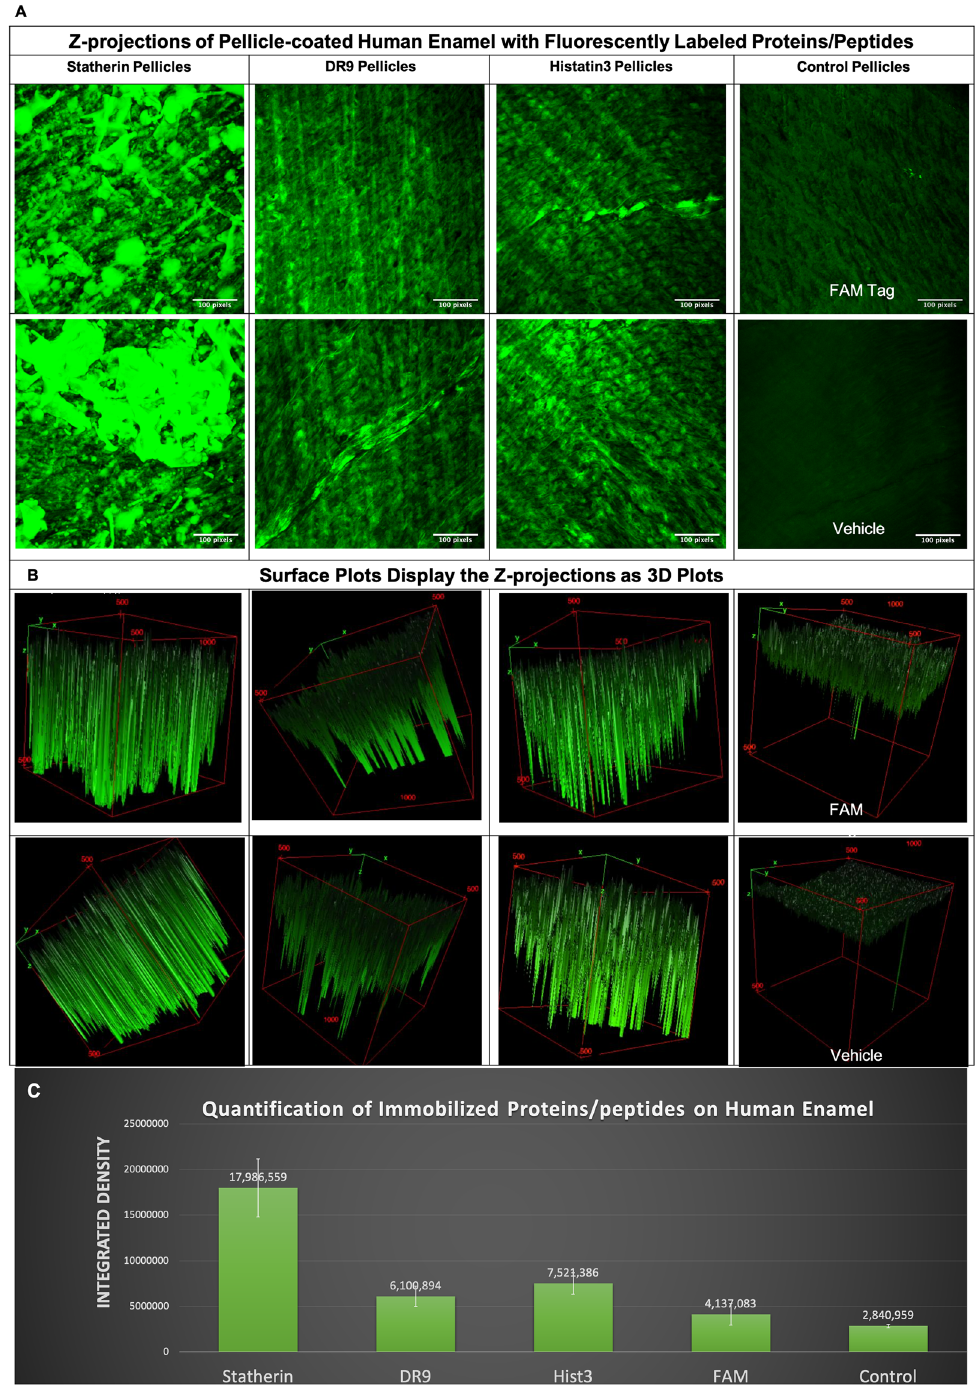
Figure 7. 2-photon Z-projections and 3D surface plots of fluorescently labeled proteins/peptides immobilized on human enamel tissue: This characterization method aimed to visualize the immobilization pattern and binding capacity of representative proteins/peptides. ( A ) Maximum intensity z-projection showing the highest attenuation value throughout the volume onto a 2D image (the scale bar is 25 μm). ( B ) Surface plots display the images in panel A as 3D plots where the z-coordinate is representing the brightness of each pixel of the 2D image. FAM tag is the fluorescent molecule used to label proteins/peptides. The vehicle is 0.01% acetic acid used to prepare the solutions of tested proteins/peptides. ( C ) Quantification of the relative intensity “integrated density” of the immobilized proteins/peptides on human enamel tissue. Bars show average ± standard deviation. Hist3,